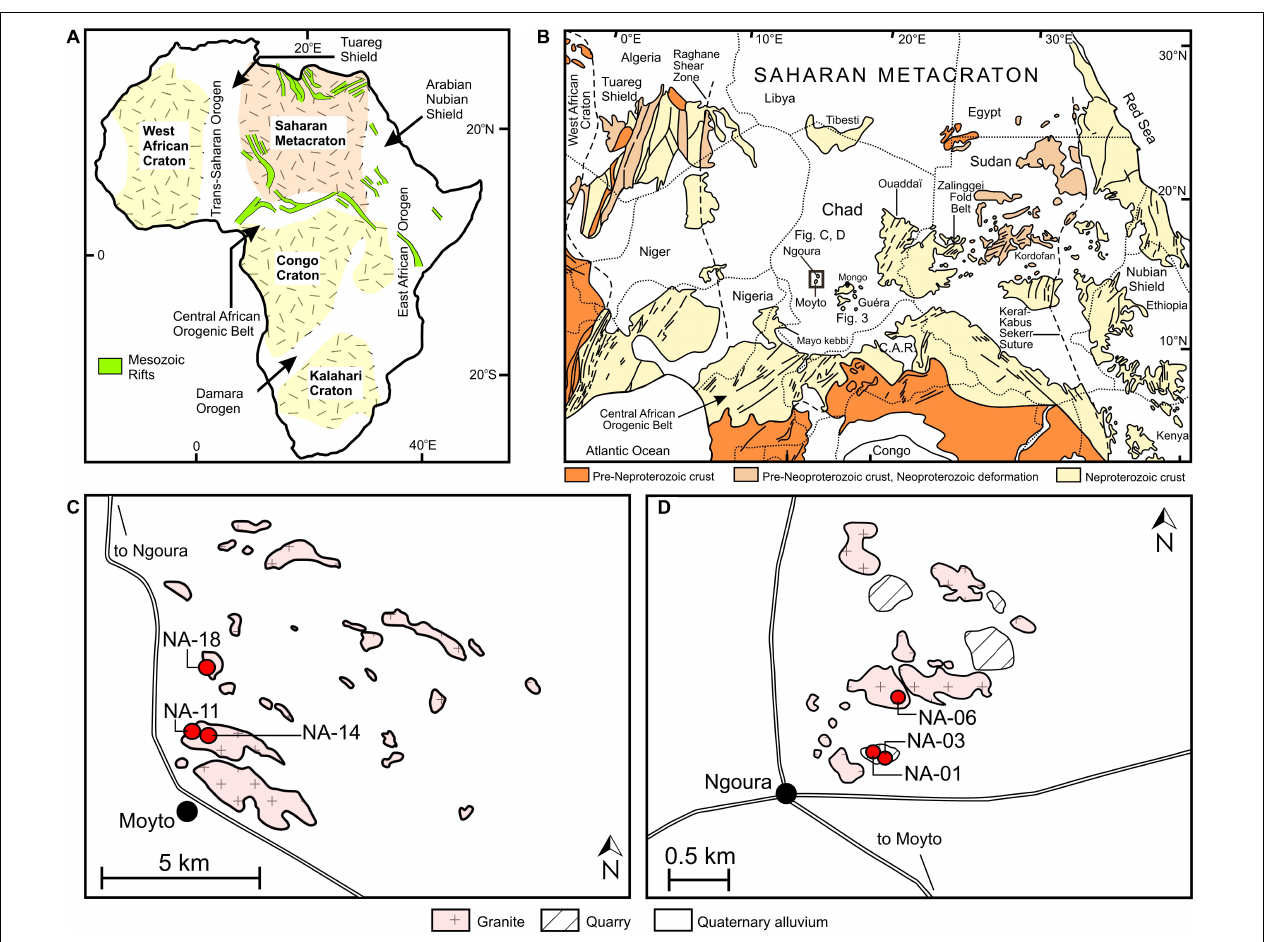
FIGURE 1 | (A) Major cratons of continental Africa and locations of Mesozoic rifts. (B) Simplified geological map of the Saharan Metacraton, showing the location of the study areas (modified from Abdelsalam et al., 2002). The sample localities of the Lake Fitri inliers near (C) Moyto and (D) Ngoura (after Shellnutt et al.,